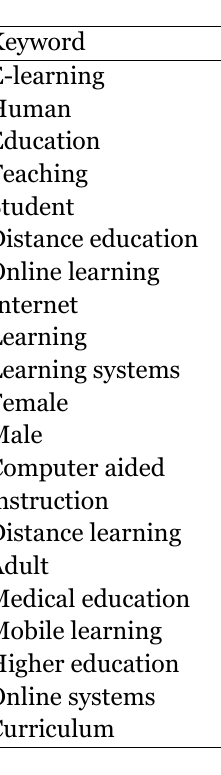
The top 20 keywords of the analyzed studies are listed in Table 2, with the top five keywords being “e-